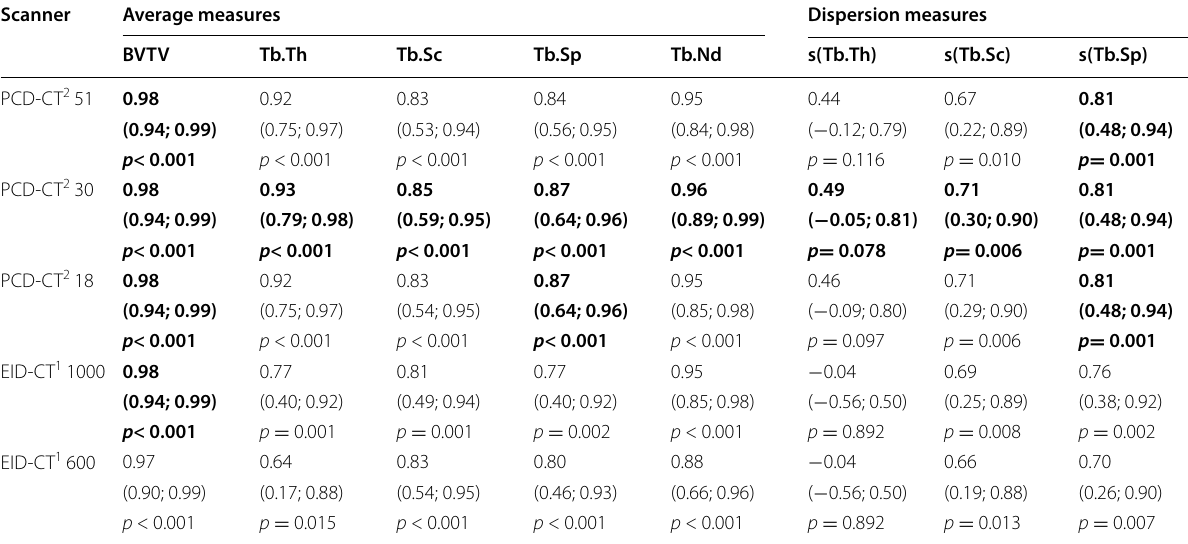
Bold numbers indicate the highest correlation for each parameter. BVTV Bone volume fraction, EID-CT Multislice computed tomography using energy-integrating detectors ( 1 ), PCD-CT Multislice computed tomography using photon-counting detectors ( 2 ), Tb.Nd Trabecular nodes, Tb.Th Trabecular thickness, Tb.Sc Trabecular spacing, Tb.Sp Trabecular separation. s(Tb.Th), s(Tb.Sc) and s(Tb.Sp) are the intra-volume standard deviation for Tb.Th, Tb.Sc and Tb.Sp, respectively. The numbers after the type of scanner correspond to the field of view in mm (PCD-CT) and quality reference tube load in mAs (EID-CT)